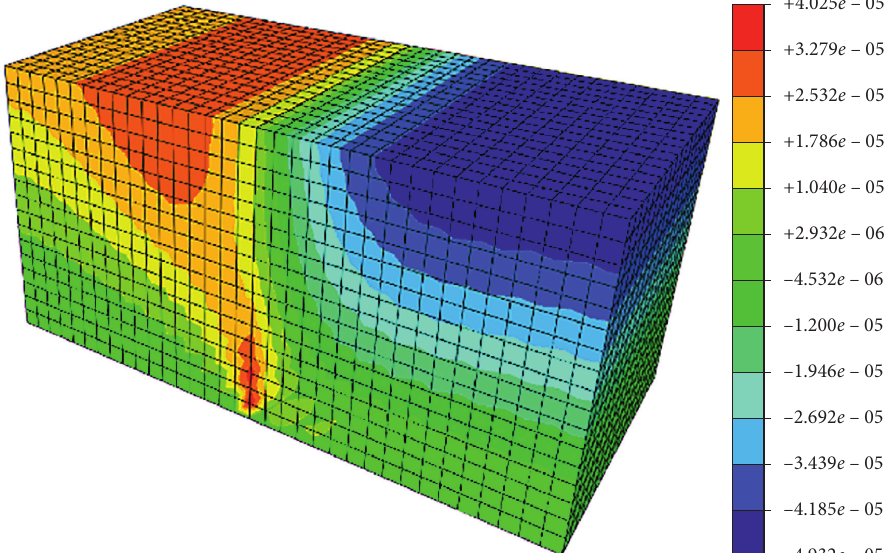
Figure 14: Vertical deformation contours of model 2 (unit: m).